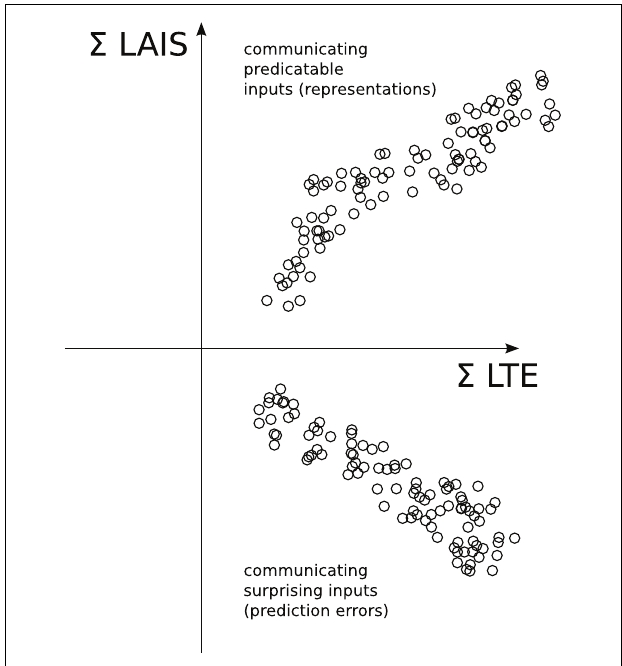
FIGURE 4 |Various information processing regimes in the information state space . Σ LAIS = sum of local active information storage in input, Σ LTE = sum of outgoing local transfer entropy. Each dot represents these values for one agent and time